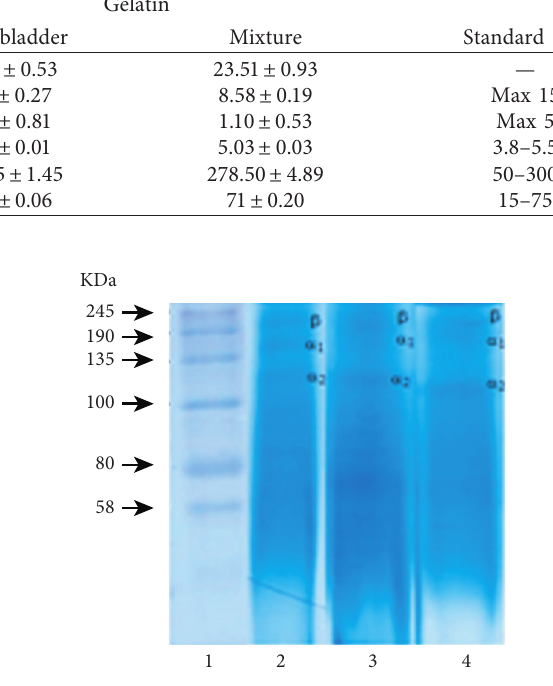
Figure 1: (1) SDS-PAGE profile of gelatin from Pangasius waste: molecular weight marker and (2) gelatin from the skin, (3) swim bladder, and (4)